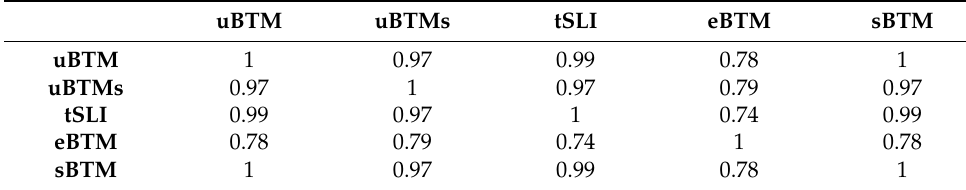
Table 1. Correlation matrix of models in Rio Grande do Sul coastal plain (RSCP).